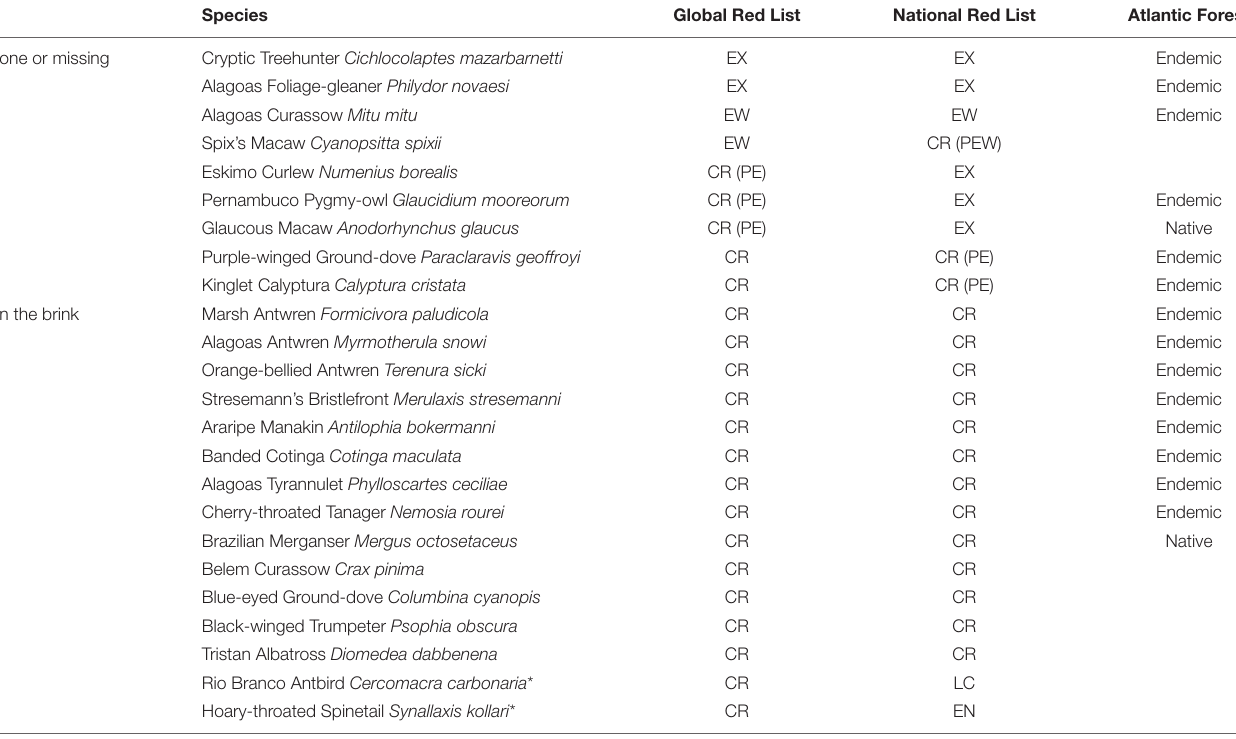
TABLE 1 | Bird species of Brazil listed as globally Extinct (EX), Extinct in the Wild (EW), or Critically Endangered (CR), including birds that are Possibly Extinct (PE) or Possibly Extinct in the Wild (PEW) (BirdLife International, 2021). Species Global Red List National Red List Atlantic